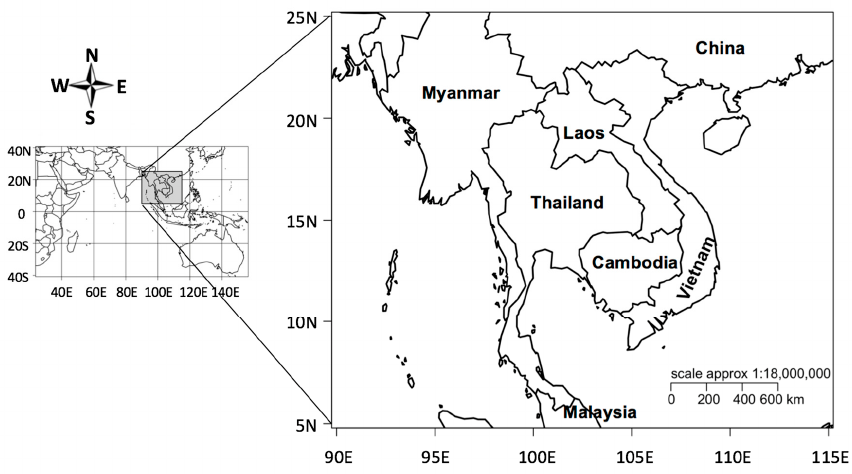
Figure 1. Map of the Indochina Peninsula (5°–25° N, 90°–115° E).